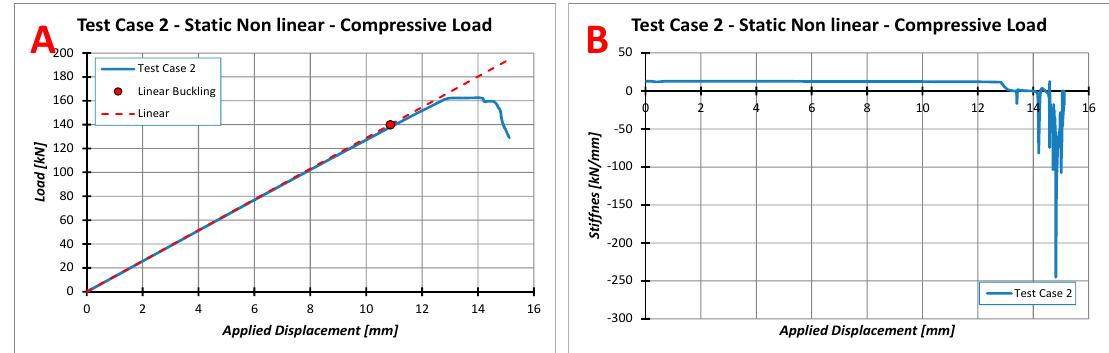
Figure 23. Test case 2—Non-linear analysis. ( A ) Load—displacement curve; ( B ) stiffness—displacement curve.